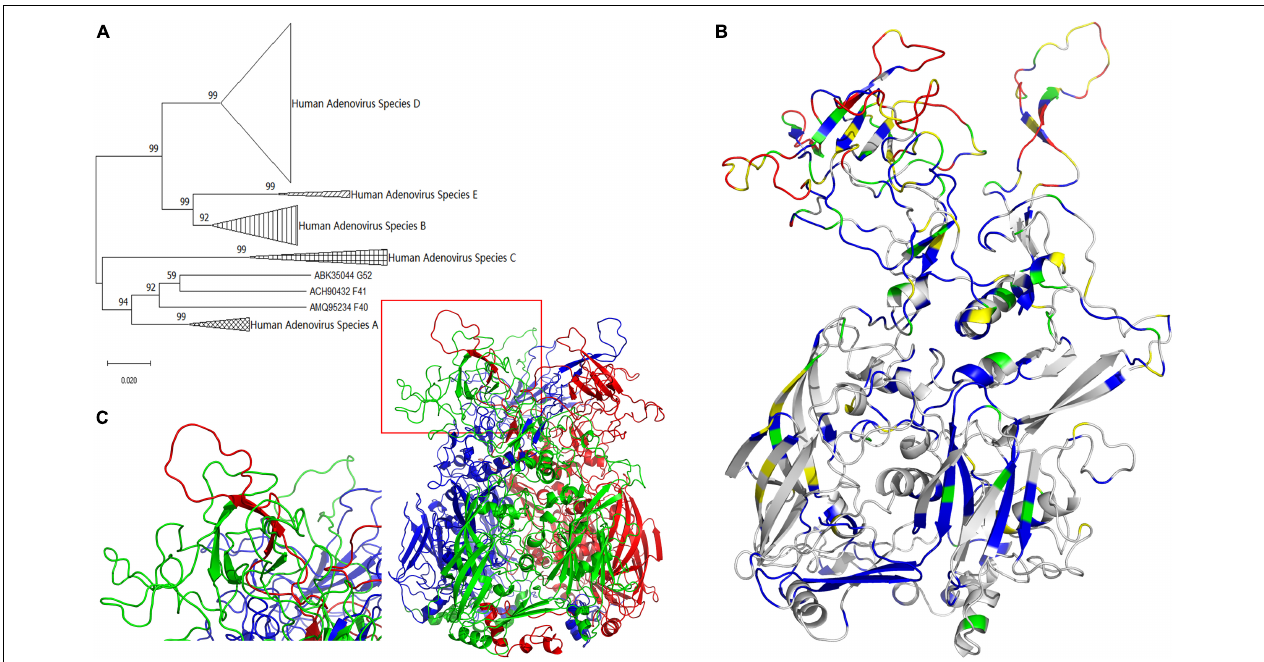
FIGURE 1 | Evolutionary trace of human adenovirus hexon. (A) The neighbor-joining tree of adenovirus was based on hexon protein amino acid sequences. The bootstrap values in percentages were shown above branches. (B) The evolutionary trace was projected to a monomer of hexon protein. Gray represents the completely conserved residues, blue represents residues with 0–0.2 variability, green represents residues with 0.2–0.4 variability, yellow represents residues with 0.4–0.6 variability, and red represents residues with variability larger than 0.6. The conservative gray and blue sites with lower variability are concentrated at the bottom, and the highly variable red and yellow spots are concentrated on the top. (C) The three-dimensional structure model of the human adenovirus hexon was drawn with the ribbon view. The adenoviral hexon was a homotrimer including three monomers colored in red, green and blue respectively. The one tower region surrounded by a red box was magnified to the lower left corner, showing this tower region was composed of an L1 Loop (in green) and an L2 Loop (in